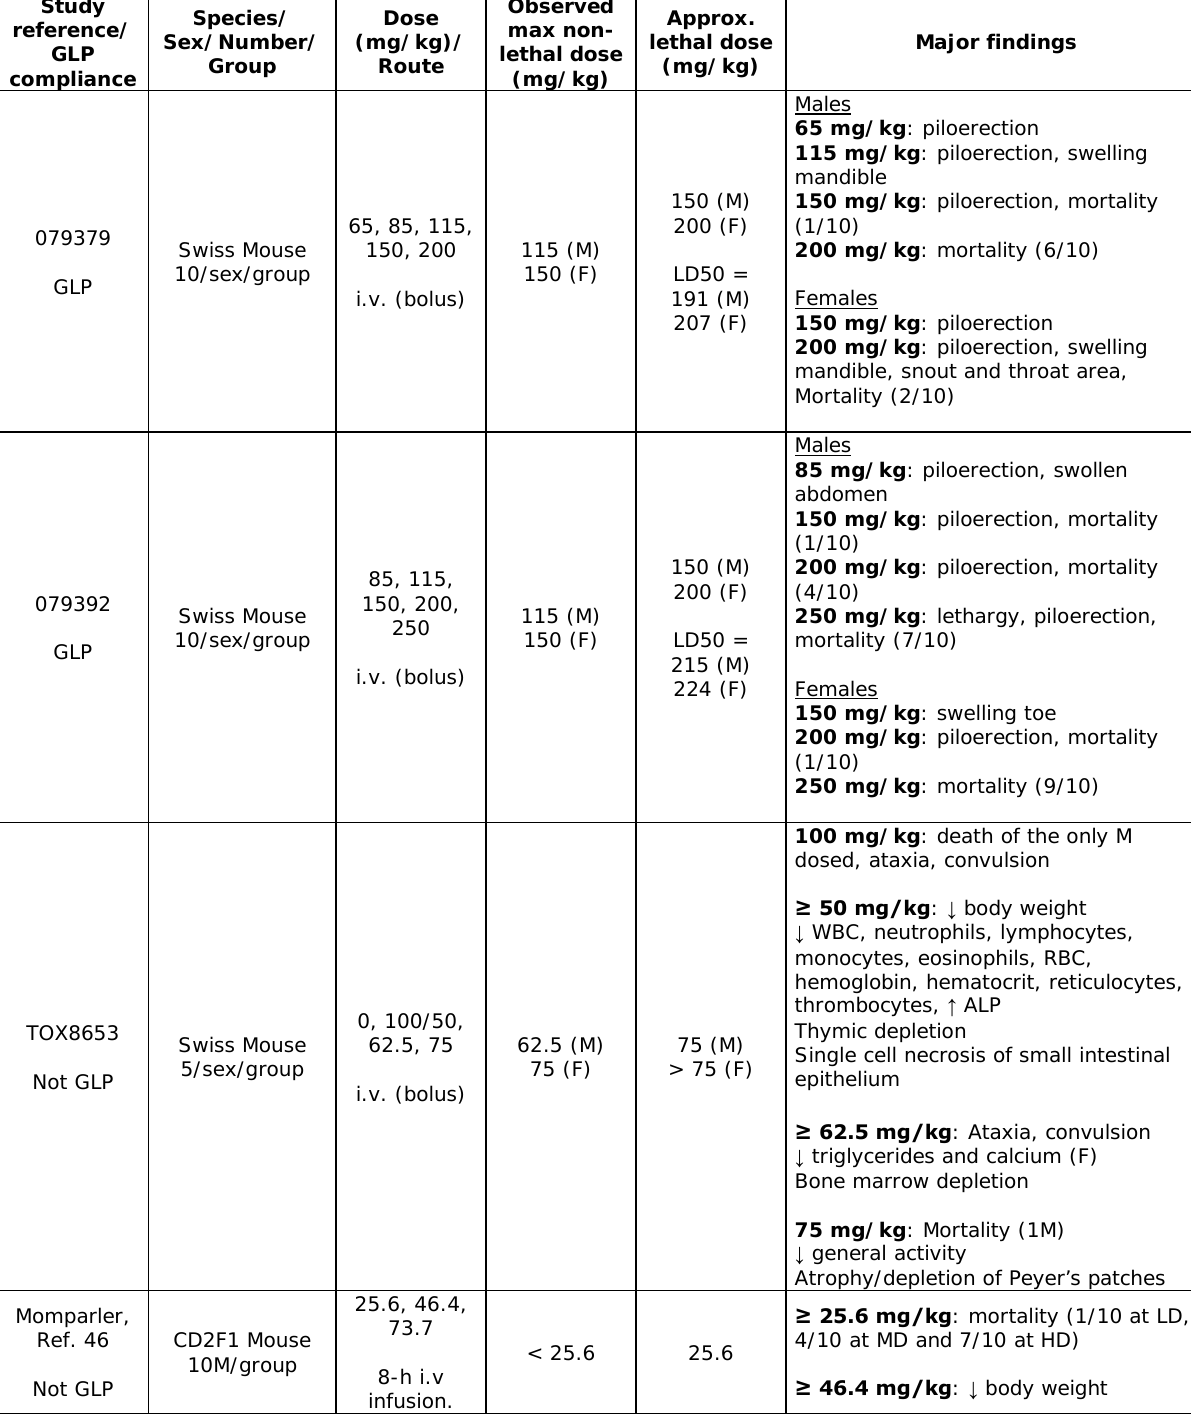
Table 5 : Summary of single dose toxicity studies Study